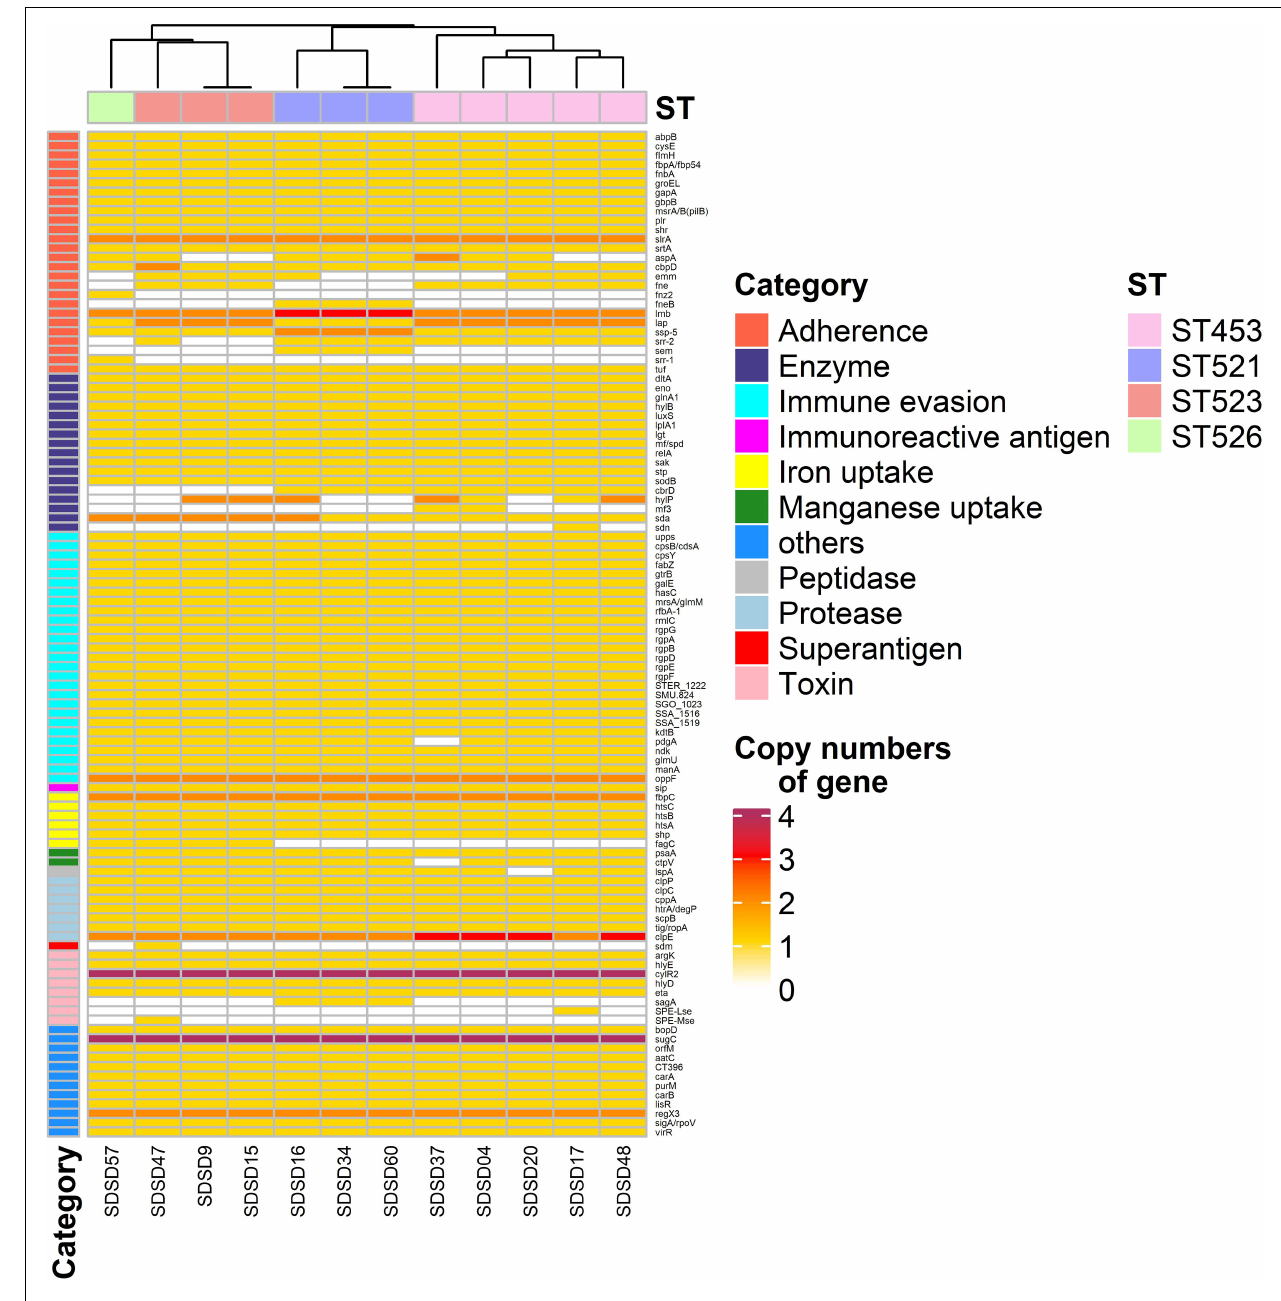
FIGURE 4 | Heatmap of virulence factor gene number distribution in 12 Streptococcus dysgalactiae subsp. dysgalactiae (SDSD) isolates. A total of 108 virulence-associated genes were determined by Virulence Factors of Database (VFDB) in all 12 SDSD strains, and the copy number, ranging from 0 to 4 were indicated by yellow to red. Eleven main virulence categories were marked with colored bars along the Y-axis. The phylogenetic tree based on the presence of virulence genes of the isolates was presented as a cladogram in the panel along the